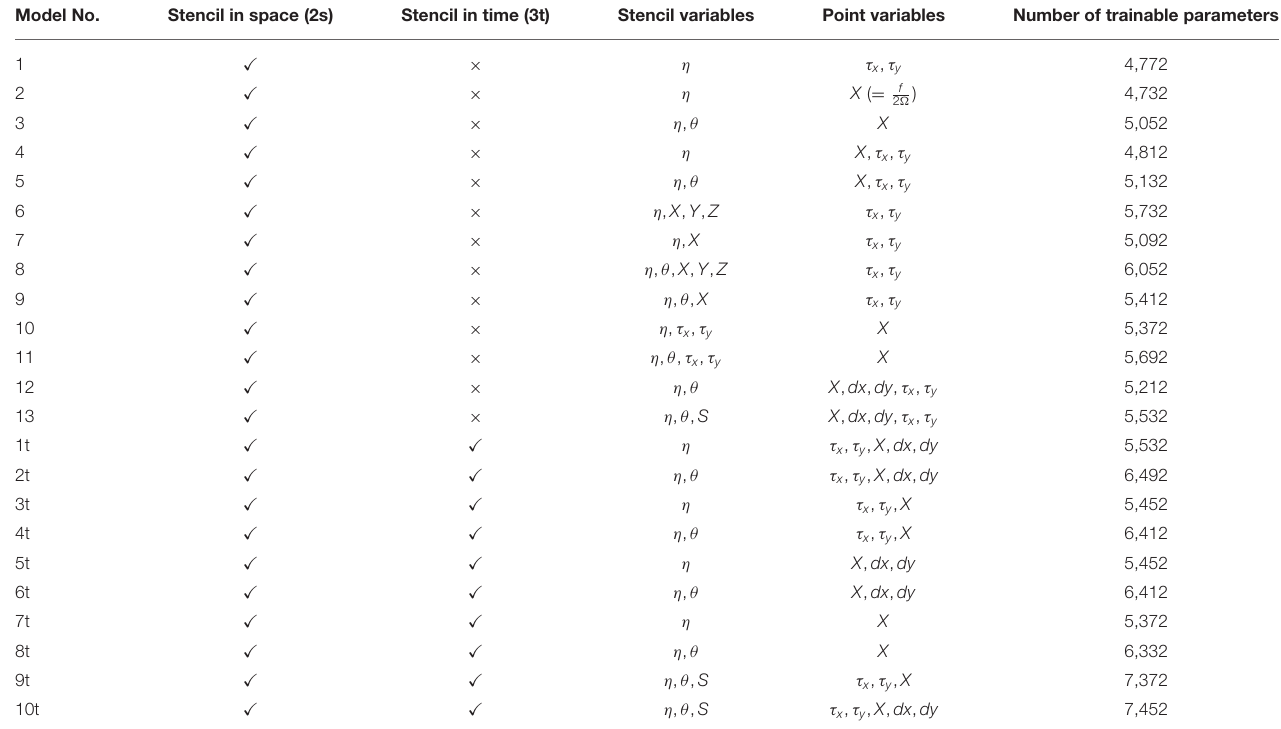
TABLE 2 | Table summarizing the different CNNs and the training strategies explored. Model